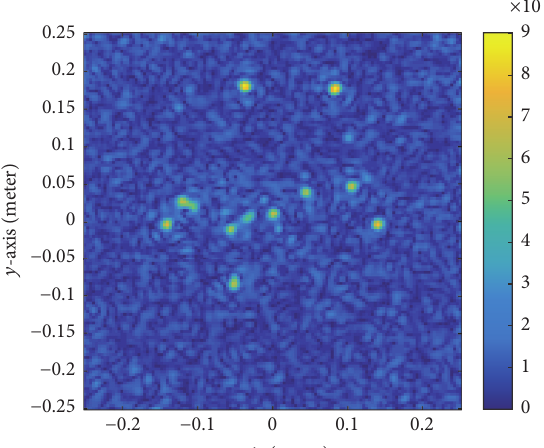
Figure 8: Initial tomographic image reconstruction of irregular complex target, showing only the dominant target before applying MRL algorithm.